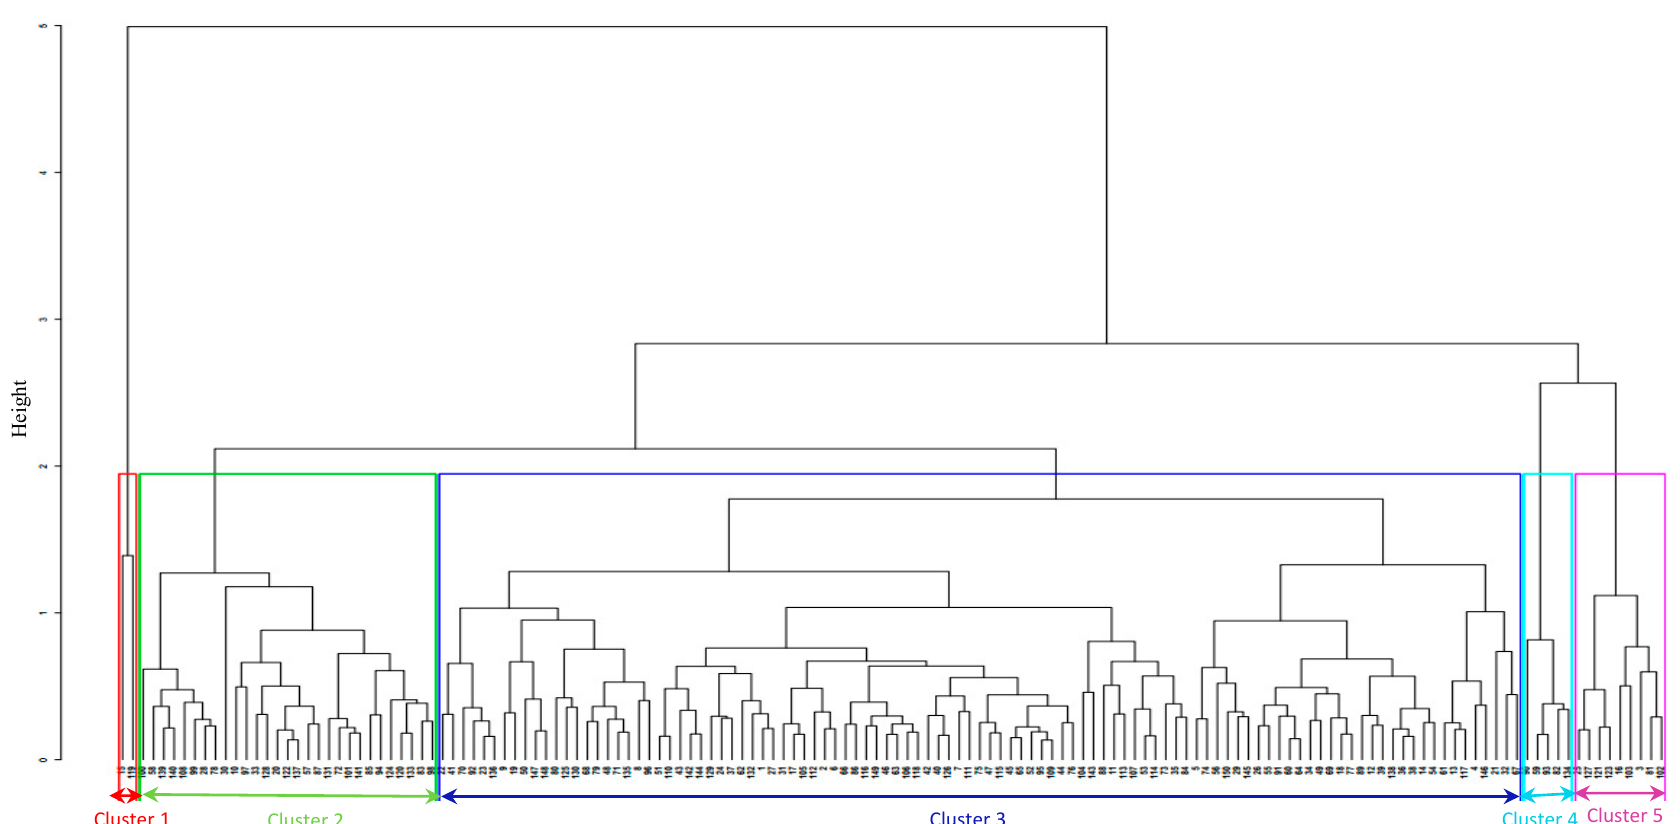
Cluster 1 Cluster 2 Cluster 3 Cluster 4 Cluster 5 Figure 1. Hierarchical cluster analysis based on agronomic traits measured under Striga infestation condition using ward.D2 method showing the genetic relationships among the 150 inbred lines based on Gower’s dissimilarity matrix.